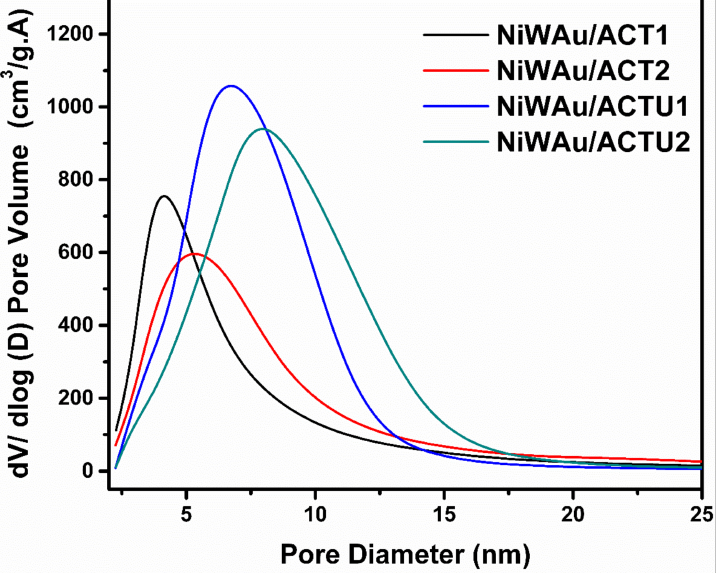
Figure 3. Pore distribution of the four supported trimetallic NPs nanomaterials synthesized by the recharge